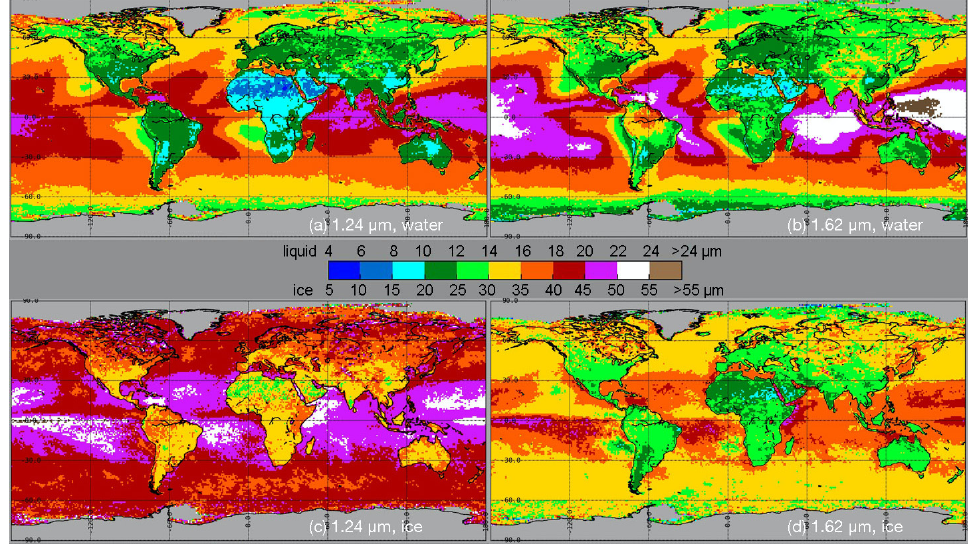
Figure 15. SNPP VIIRS Ed1a 2013 mean CER for liquid water clouds at ( a ) 1.24 µm and ( b ) 1.62 µm, and for ice clouds at ( c ) 1.24 µm and ( d ) 1.62 µm, 2013.